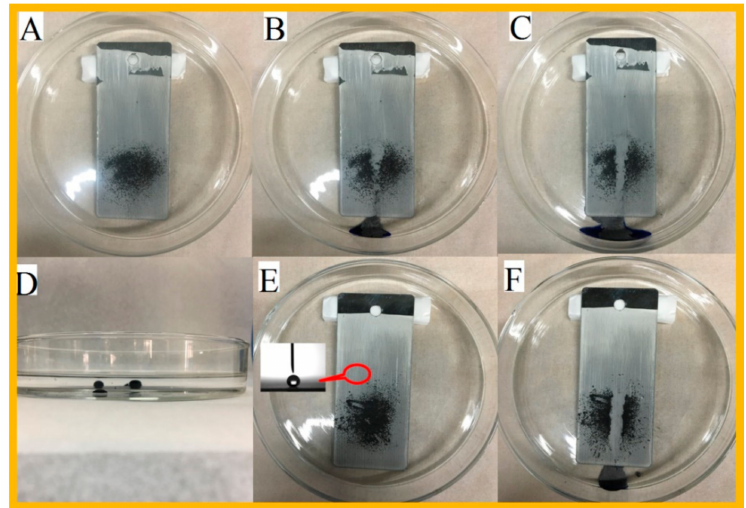
Figure 7. Self-cleaning test in air and oil. ( A ) The surface was covered by graphite, ( B , C ) process of self-cleaning in air, ( D ) water droplet was repelled by the surface in oil (hexamethylene), ( E , F ) the surface after being contaminated by oil without further water